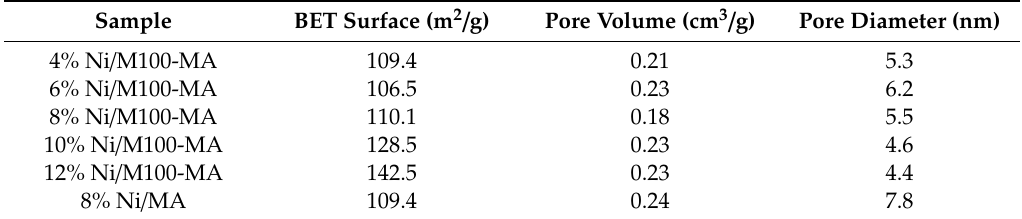
Figure 1. N 2 adsorption–desorption isotherms ( a ) and pore size distribution ( b ). Table 1. Surface area and pore parameters of the samples.